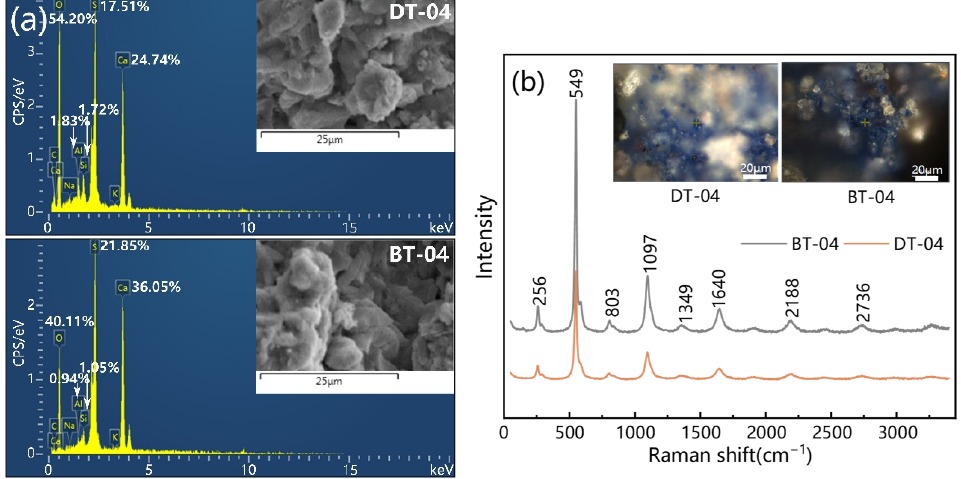
Figure 7. ( a ) Elemental analysis by SEM-EDS and ( b ) Raman spectra for the blue samples (DT-04 and BT-04).